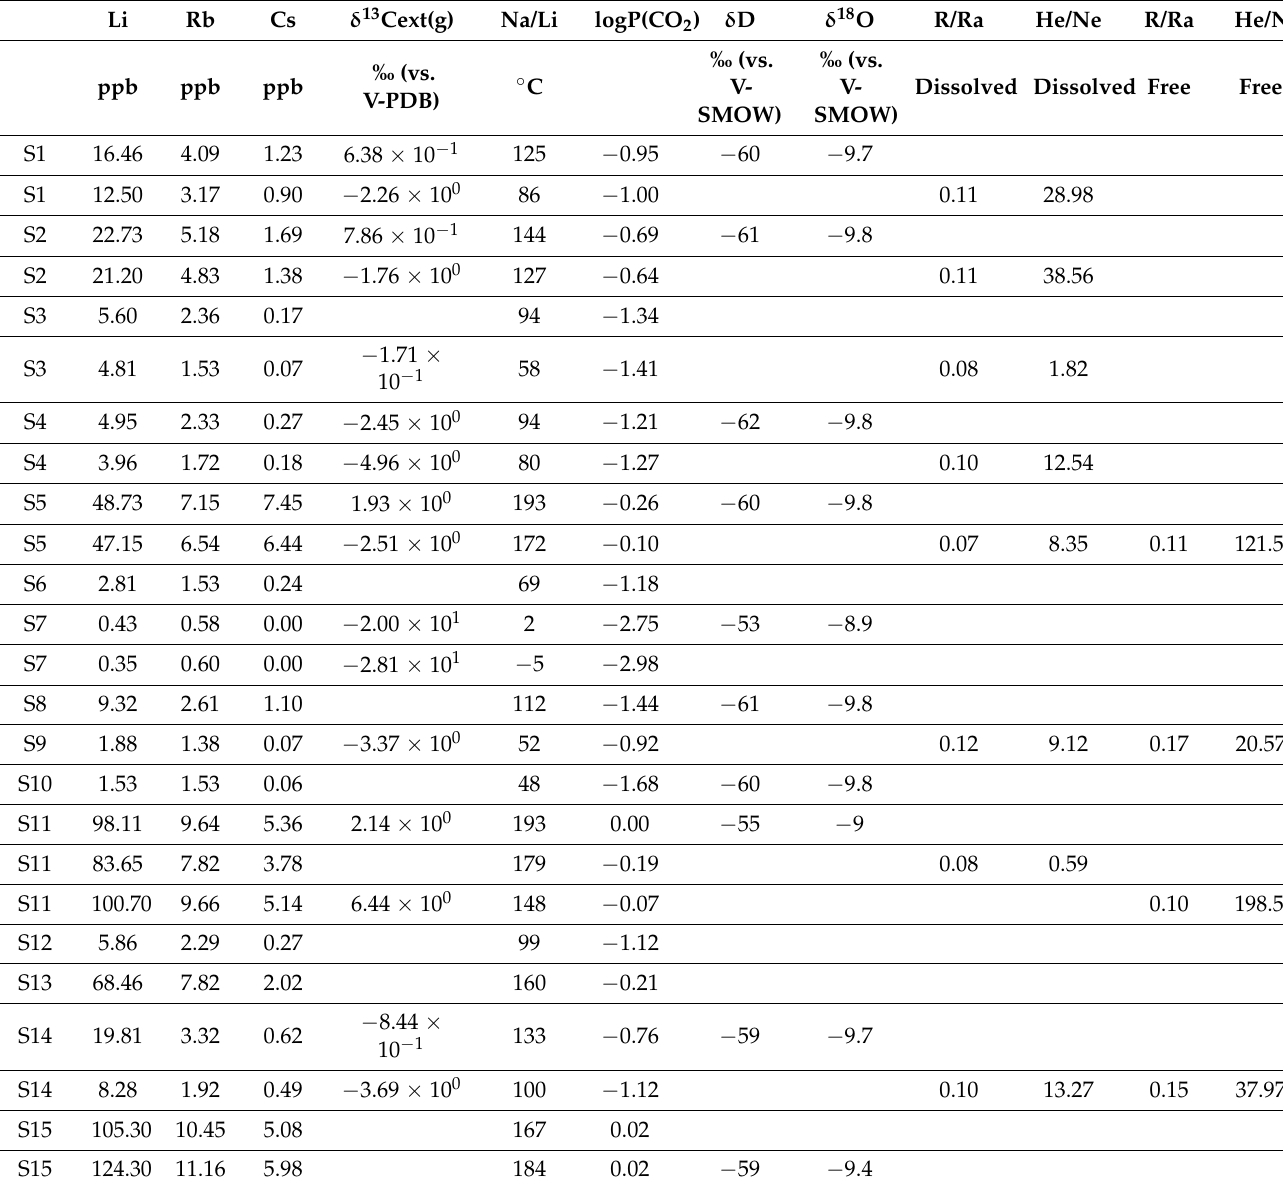
Table 1. Chemical results used in this paragraph. Same spring analyses (location in Figure 1) refer to subsequent